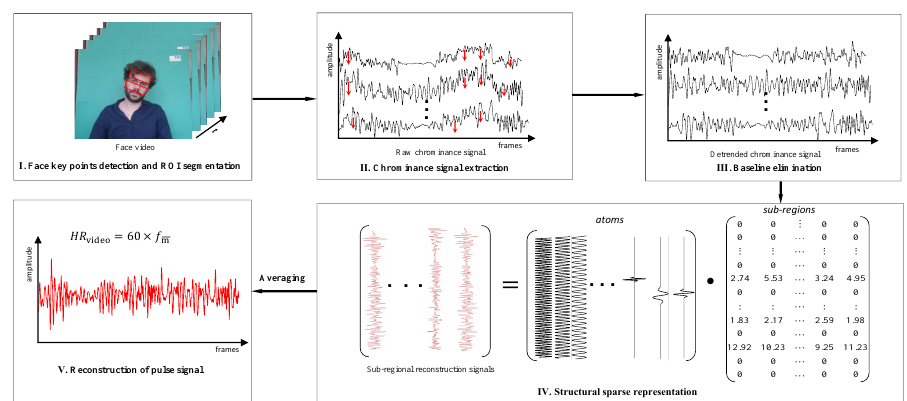
Figure 2. The overall framework of SSR2RPS. As shown in the figure, it includes the ROI segmenta- tions, extraction of chrominance signal, de-trending for the chrominance signal, sparse decomposition, and estimation of heart rate averaged over all